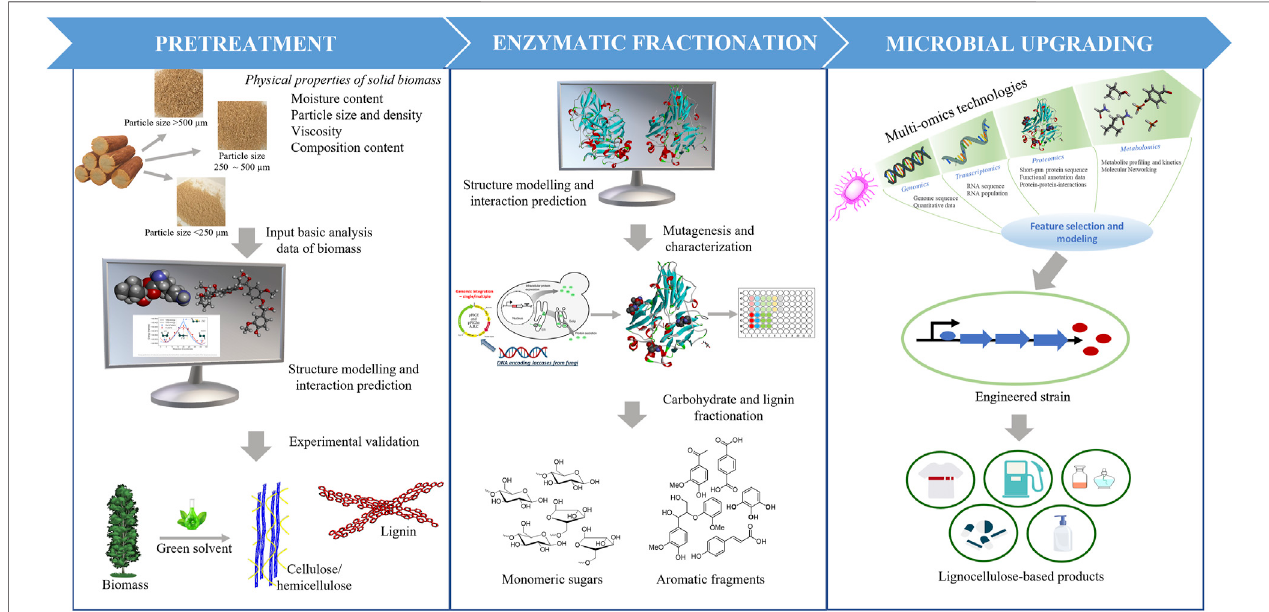
FIGURE 1 | Computational strategies used in process optimization for lignocellulose biomass deconstruction and upgrading to valuable fuels and chemicals.